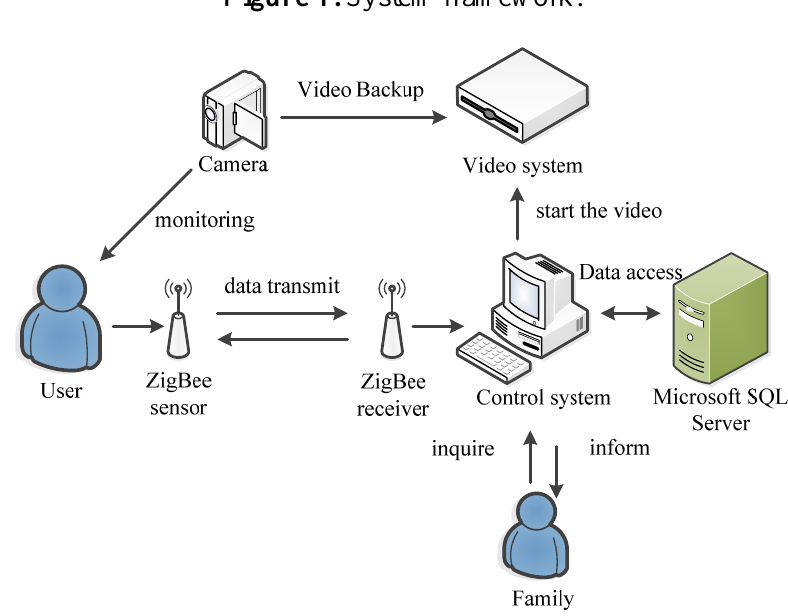
Figure 1. System